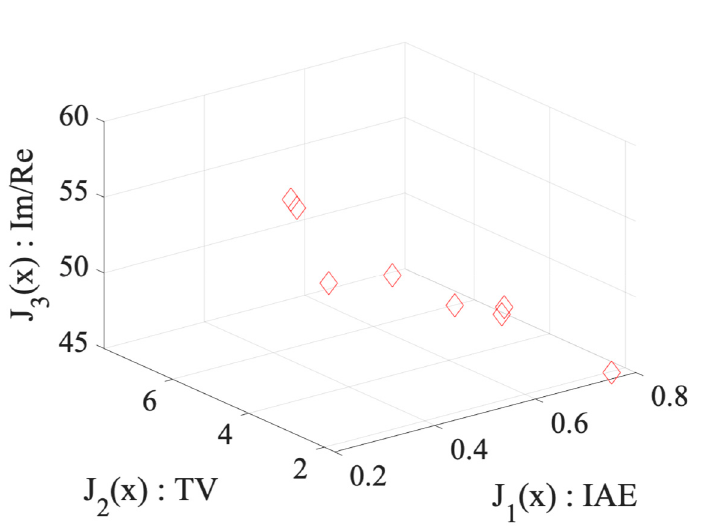
Figure 1. Pareto front approximation for the multi-objective problem